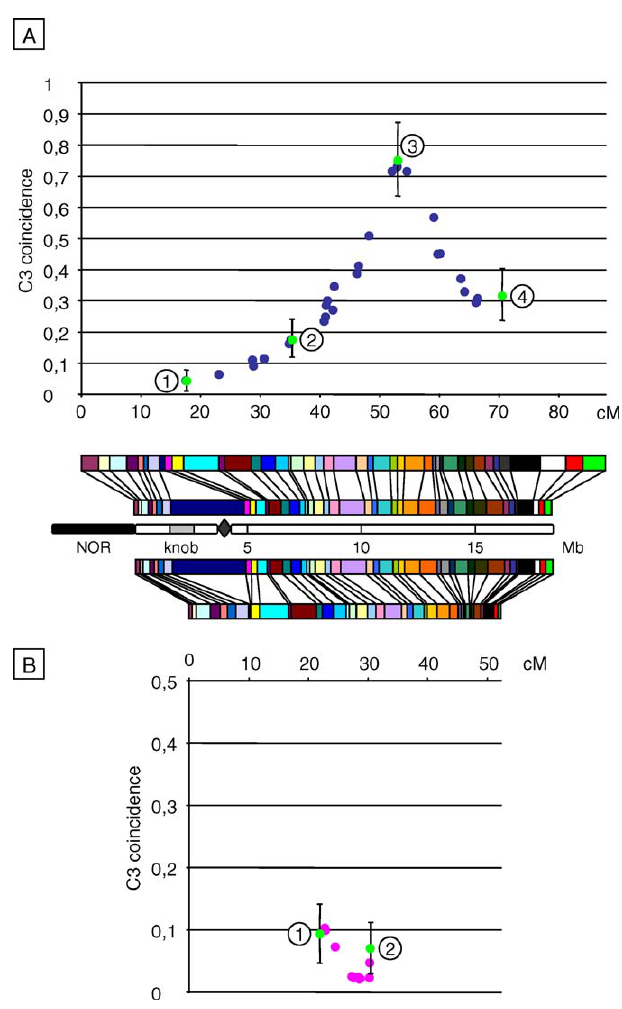
Figure 6. C3 Coincidence Plots along the (A) Male or (B) Female Chromosome 4 All possible pairs of adjacent intervals (each being 17.5 cM 6 5%) were used for calculation of coefficient of coincidence, defined as the frequency of double-COs divided by the frequencies of COs in both intervals (see Materials and Methods). These C3 coincidence values were plotted against the genetic position of the junction between the two adjacent intervals. Blue and pink dots represent, respectively, M and F datasets. Numbered green dots mark the pairs of intervals used for statistical comparison of C3 coincidence values. Error bar for these dots correspond to the standard deviation of coincidence calculated according to [35]. Each plot is aligned with the corresponding genetic map, the physical map, and a schematic representation of the chromosome, which includes 5-Mb scale coordinates, centromere (diamond), heterochromatic knob (gray box), nucleolar organizer region (NOR, black